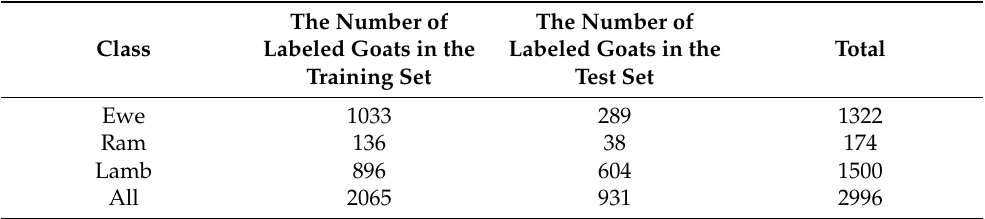
Table 1. Information on the dataset used for our experiments.